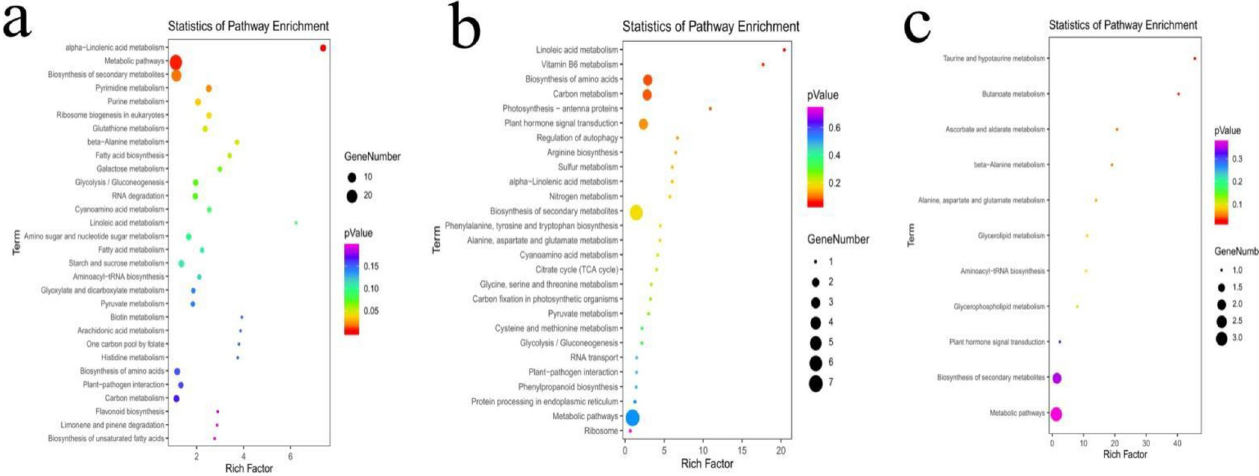
Fig 8. KEGG pathway enrichments of the cis -target genes in rapeseed buds. a-c: 1258A_SB vs_1258A_MB, P5A_SB_vs_P5A_MB and P26R_SB_vs_P26R_MB KEGG pathway enrichment. The size of each circle represents the number of significant differentially expressed cis -target genes enriched in the corresponding pathway. A pathway with a p -value < 0.05 is considered to be significantly enriched.